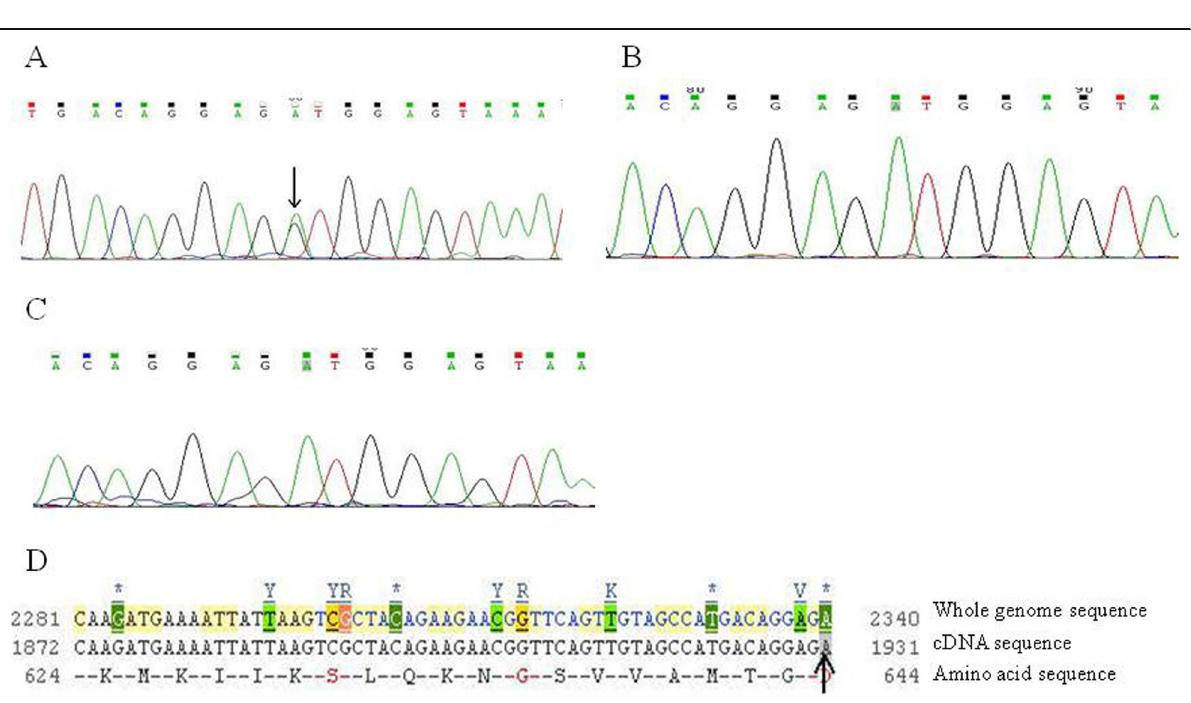
Fig. 6 Exon 22 sequencing for the ATP2C1 gene in sporadic case II. a Sequencing result of exon 22 in sporadic case II. b Sequencing result of exon 22 for normal member in the same pedigree. c Sequencing result of exon 22 for normal individual without blood relation. d A missense mutation c. A1931G(Bases A → G) in exon 22 of ATP2C1 gene in the Ensemble database (indicated by arrows)